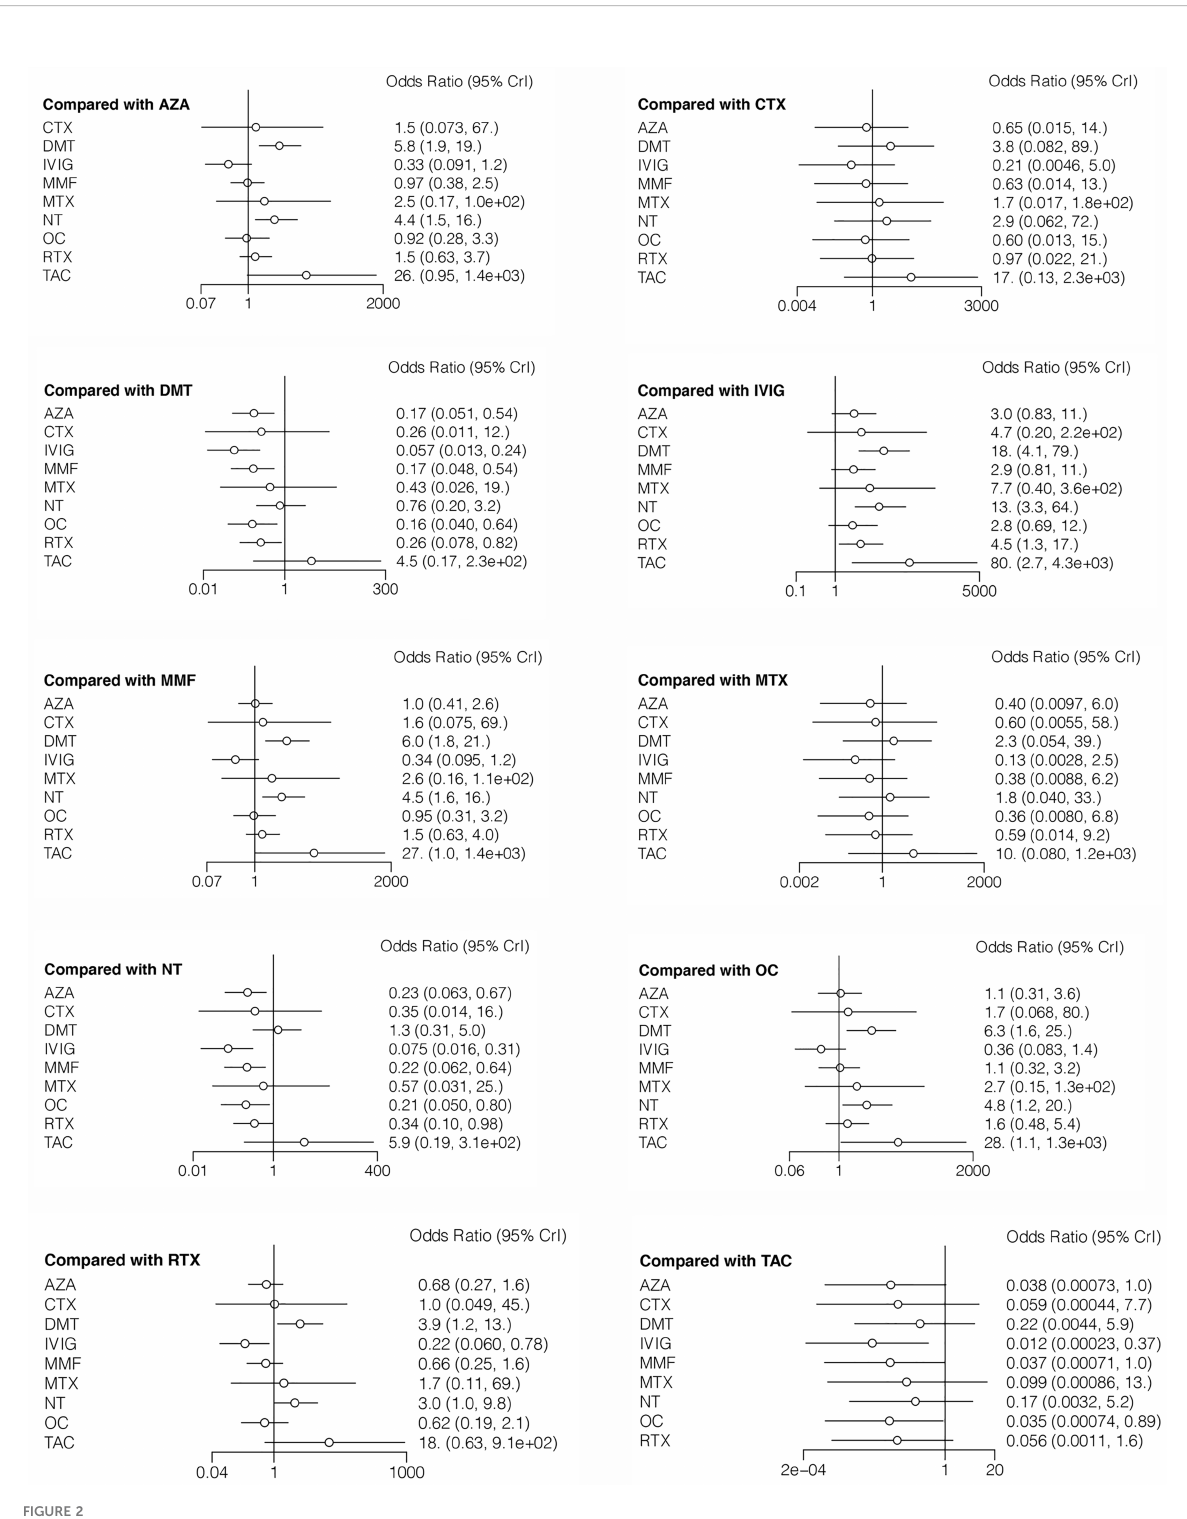
FIGURE 2 Forest plots of network meta-analysis for incidence of